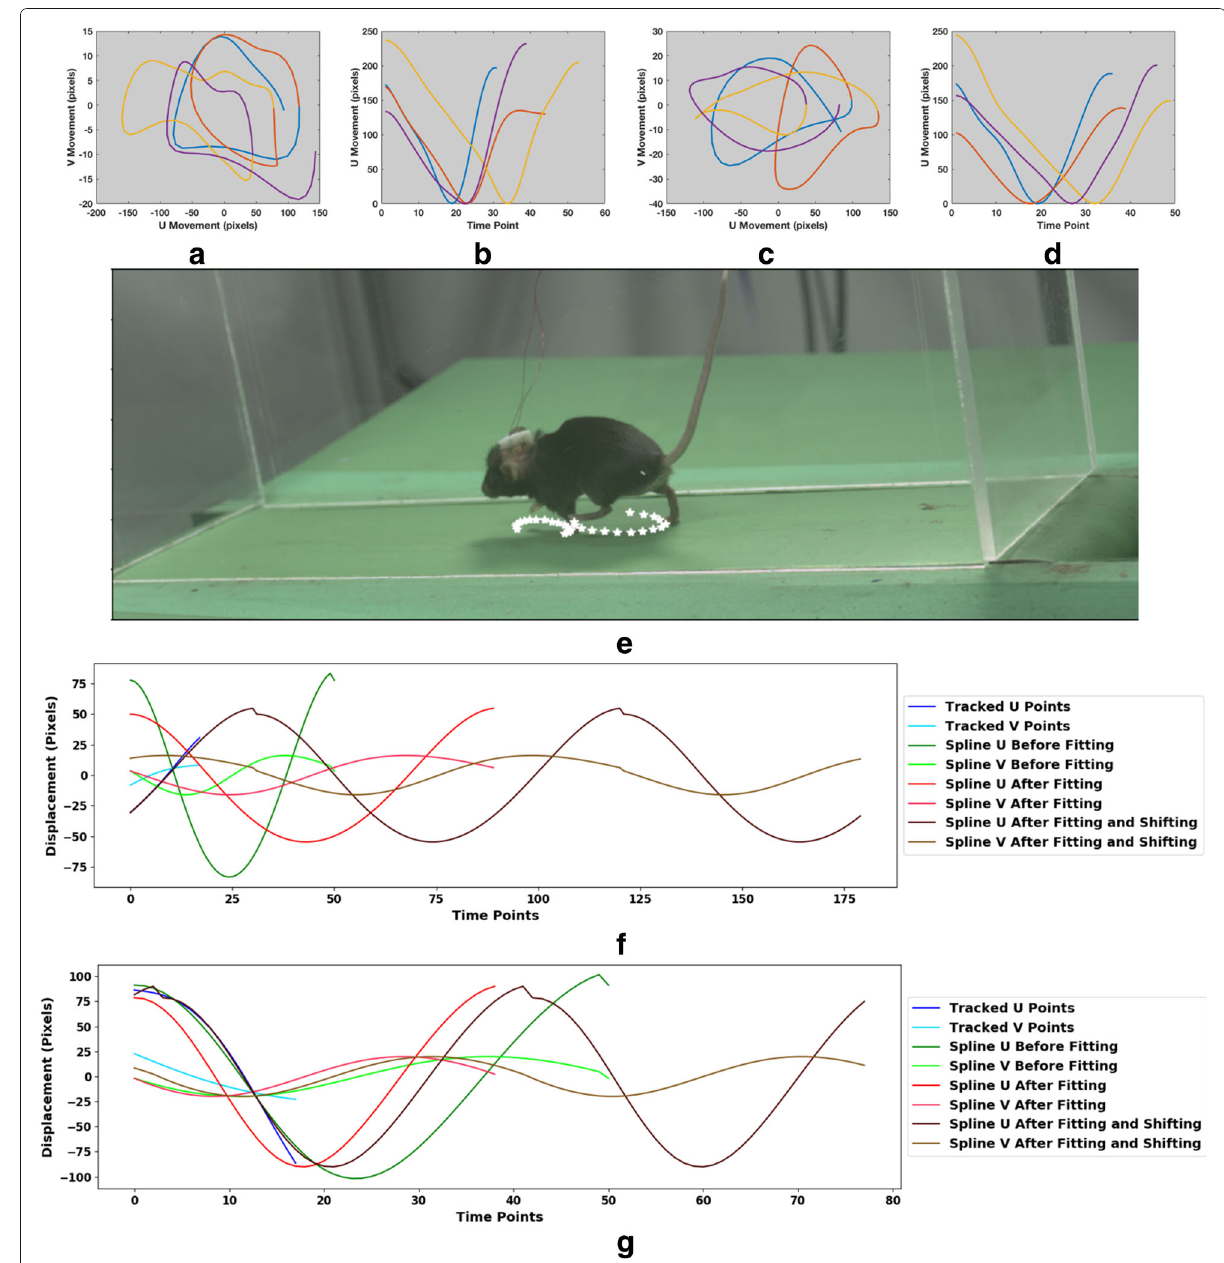
Fig. 5 Utilization of a spline function for tracking through collisions. The front paw motion pattern in the U − V plane, the front paw motion pattern in the U direction, the hind paw motion pattern in the U − V plane, and the hind paw motion pattern in the U direction for four consecutive strides are illustrated in a , b , c , and d , respectively. In panels a to d, the colors show different strides. Panels b and d show the coordinates shifted up to have the same minimum number (zero). The plots in the U − V plane are shifted to have approximately the same start point. The predicted points for future frames when “collision type II” occurs are shown in e . Front and hind paw predicted locations based on previously tracked points are illustrated in f and g , respectively. Each of these two plots contains the spline function (which is generated from a previously studied mouse with a constant speed of 30 cm/s and averaged from ten strides) before fitting, after fitting of the spline templates to the tracked paw coordinates by applying “frequency of paw locomotion” and not time shift, and final spline function helping the prediction of paws location when “collision type II” happens. It should be noted that fitting is applied for the U coordinates, and the V coordinates are moved accordingly. Finally, two cycles of splines are considered to make sure that the trajectory of coordinates will be